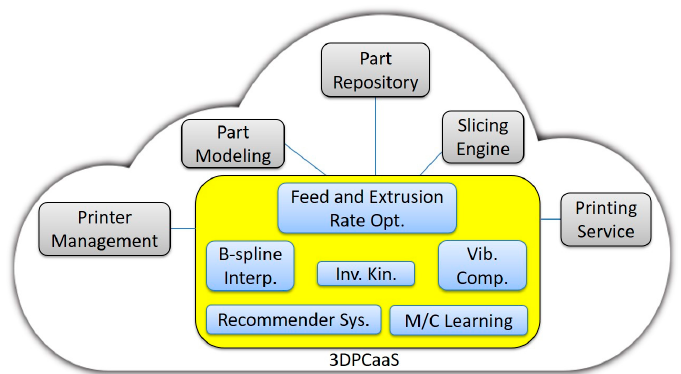
Figure 10. Example of components of existing cloud-based 3D printing ecosystem integrated with 3DPCaaS.